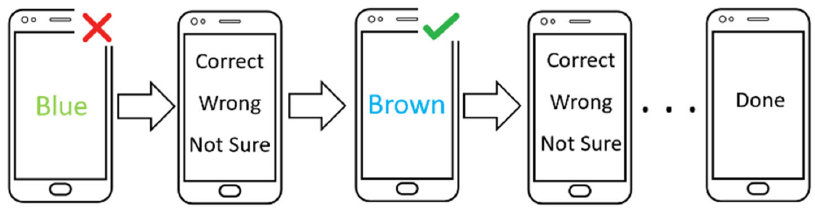
Figure 3. Flow design of the game.